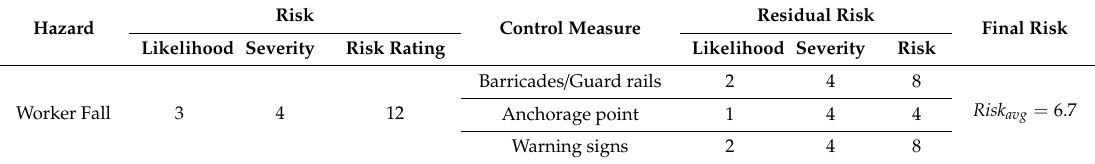
Table 5. Example of design-for-safety review template.